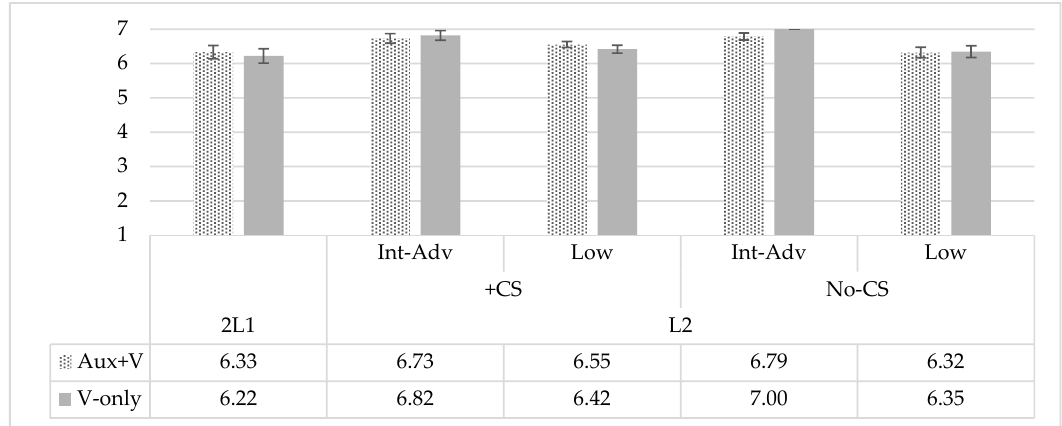
Figure 2. Monolingual Spanish verb stimuli ratings by group and type.